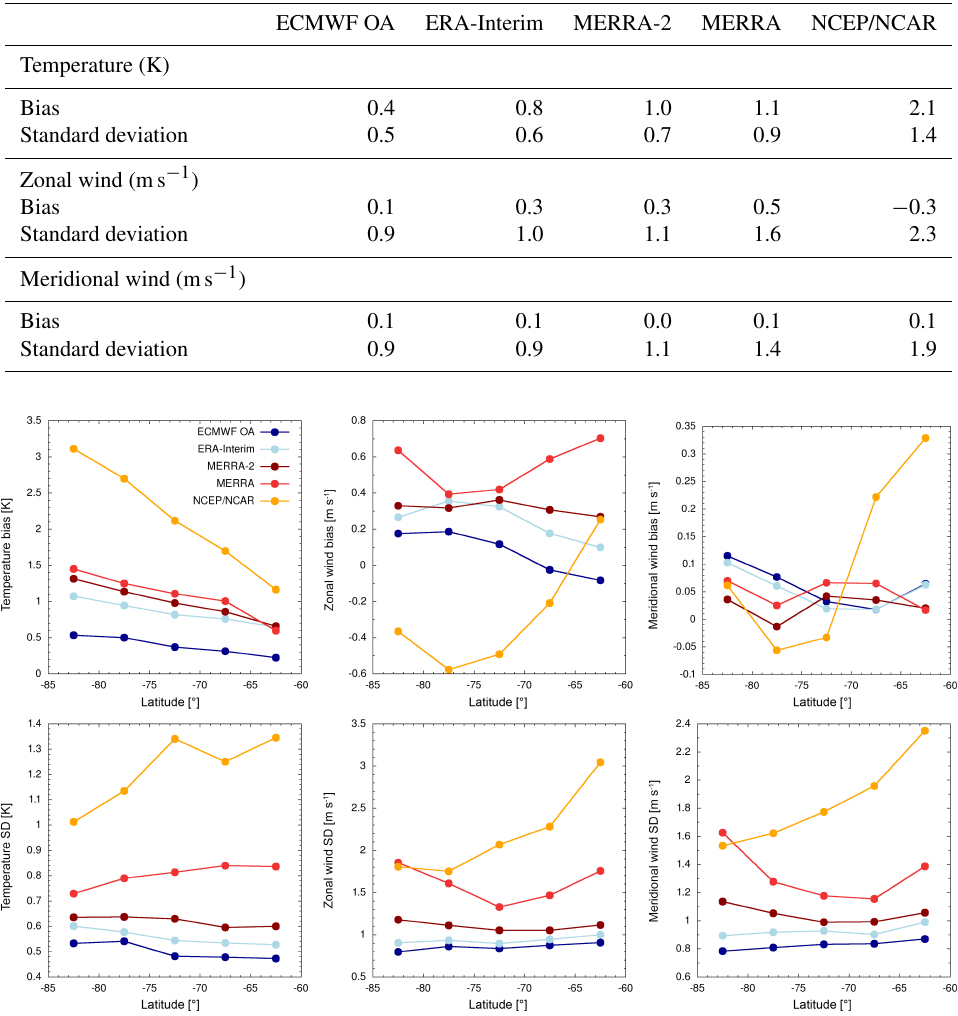
Figure 5. Bias and standard deviations of temperature and horizontal winds of meteorological analyses minus Concordiasi balloon data at different